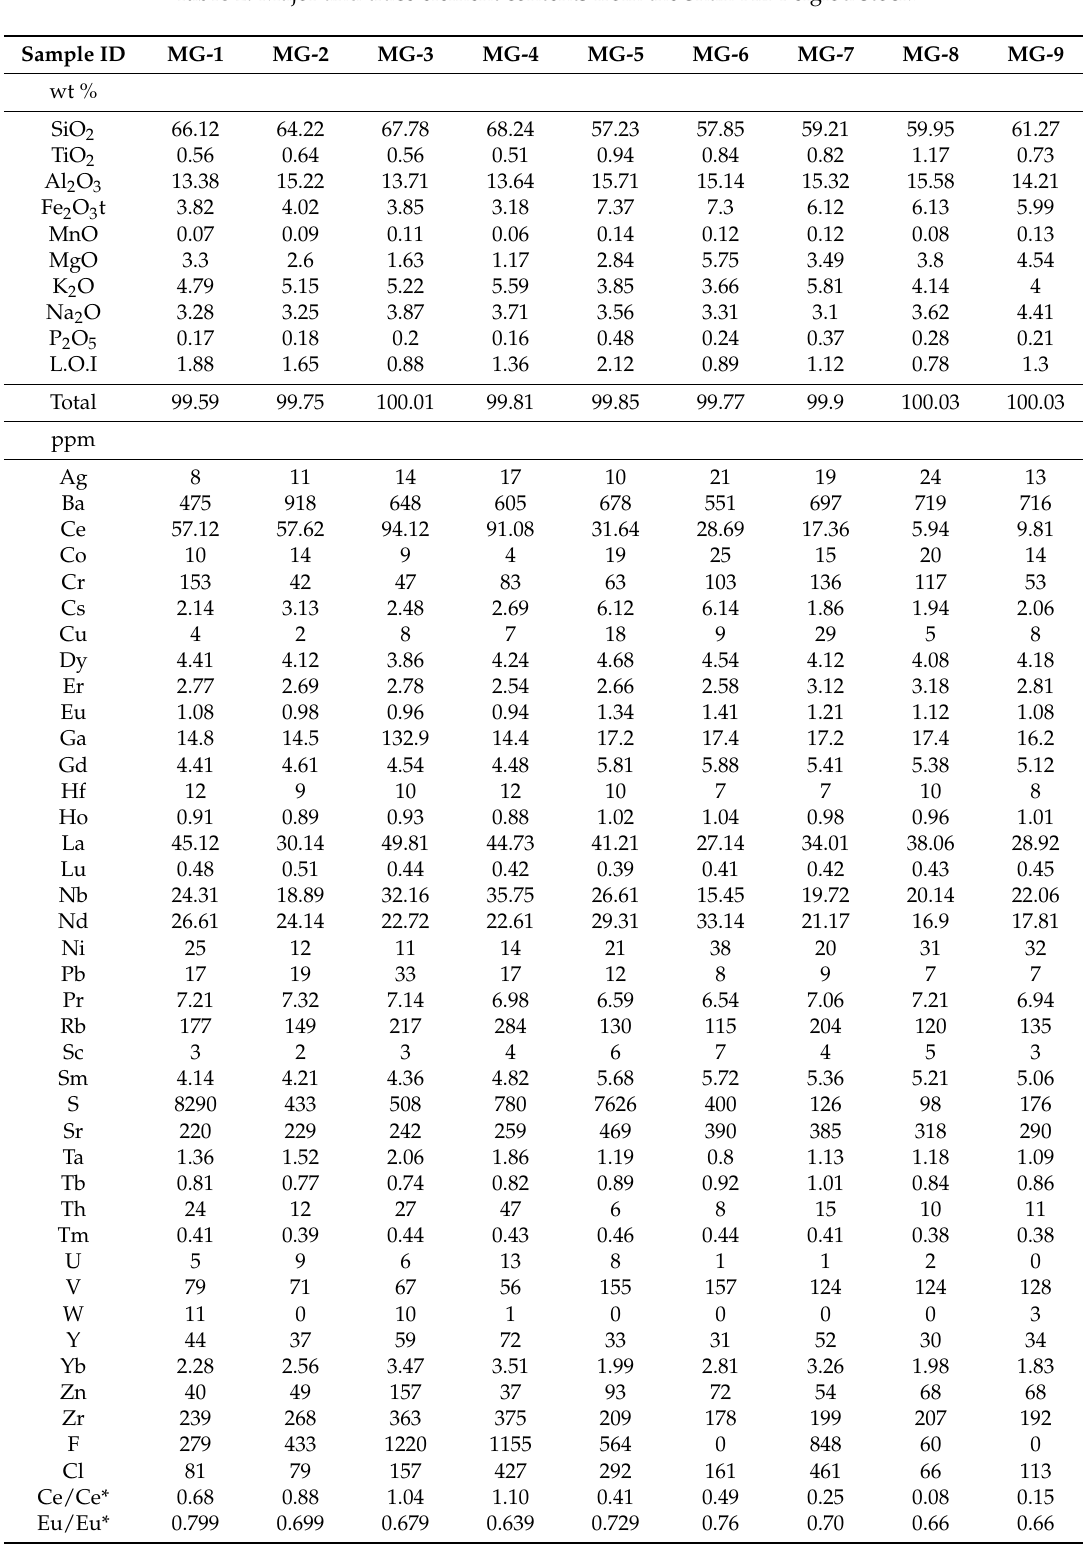
Table 2. Major and trace element contents from the Shah-Ali-Beiglou